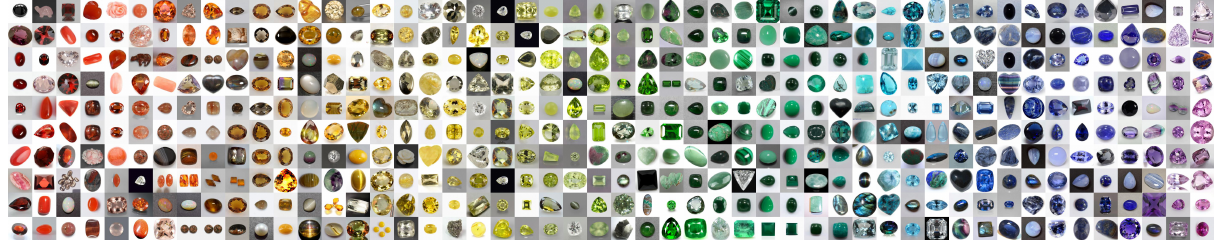
Figure 1. Five hundred images of gemstones selected from eighty-seven different categories, from Al- mandine to Zoisite. The images are arranged by hue to illustrate the difficulty of identifying the gems by visual